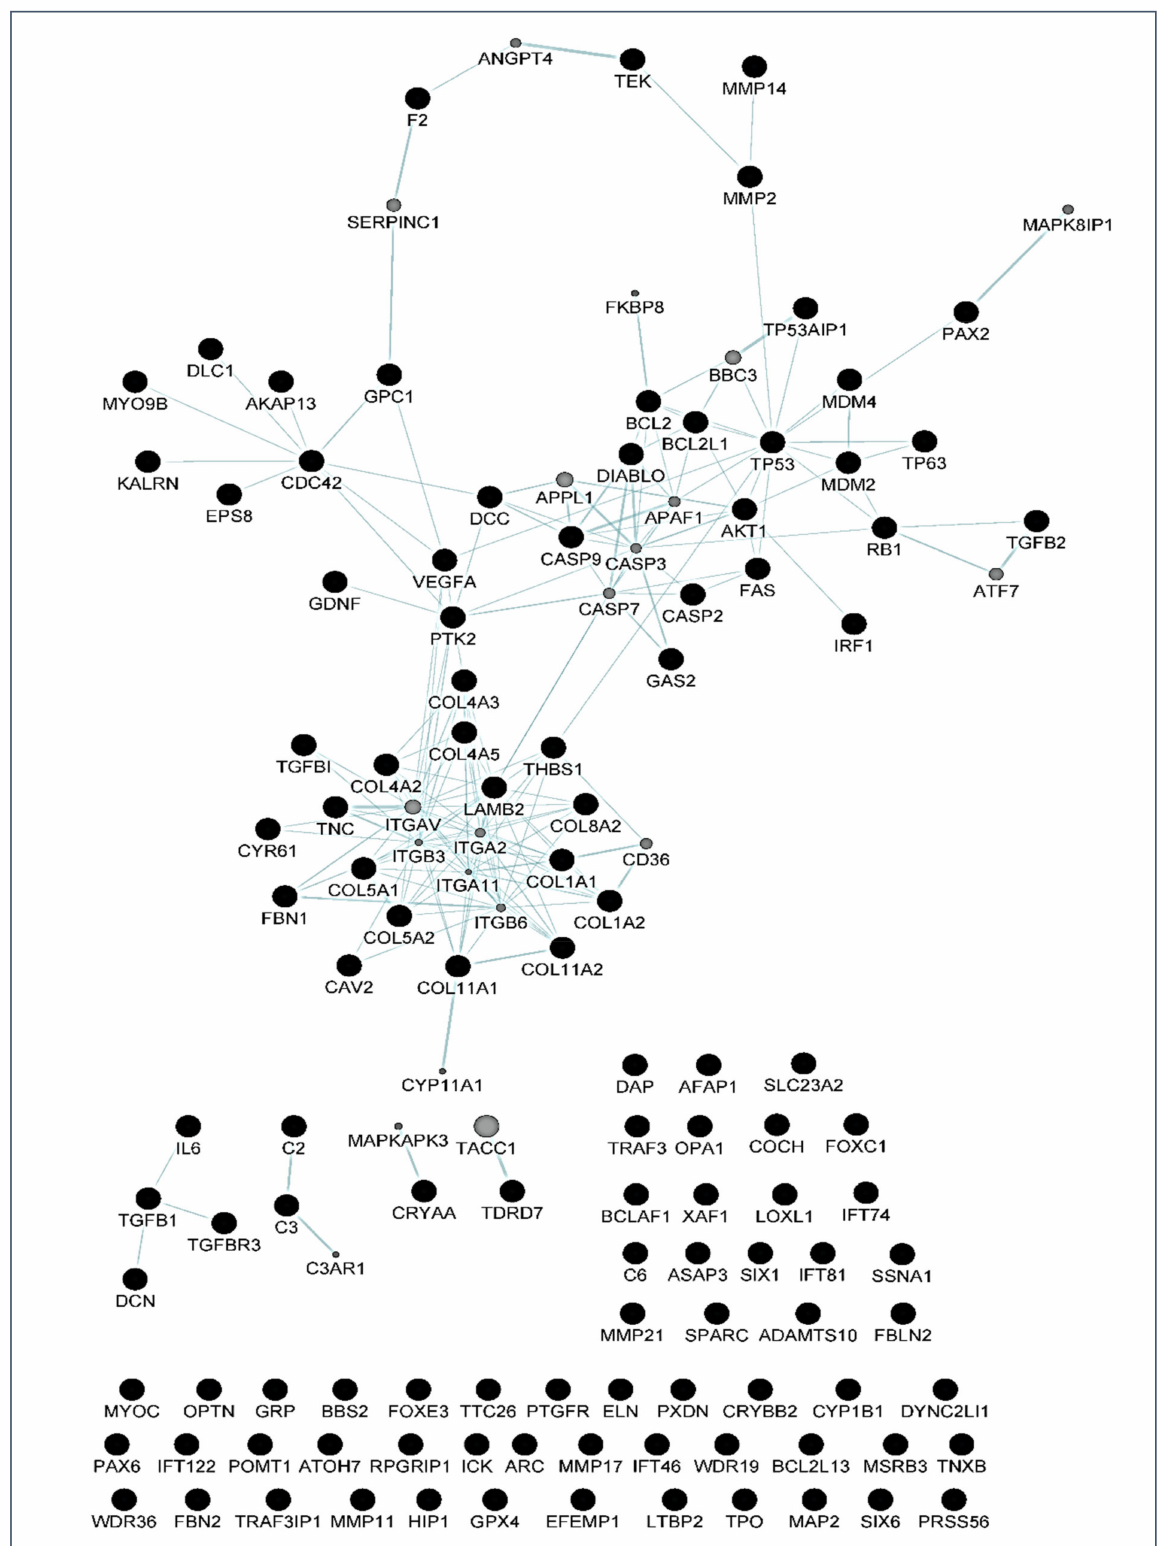
Figure 6. Metabolic pathway map created with GeneMania. Two gene products are linked if they participate in the same reaction within a pathway. Size of gray nodes indicate the likelihood of the gene belonging to the pathway (score), and thicker lines (edges) indicate a stronger relation. Data are collected from various sources such as Reactome and BioCyc, via